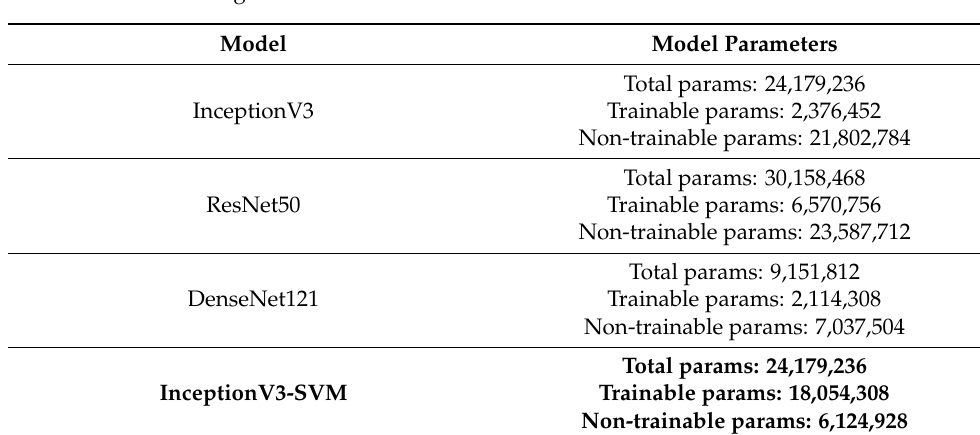
Table 5. Model Training Parameters.